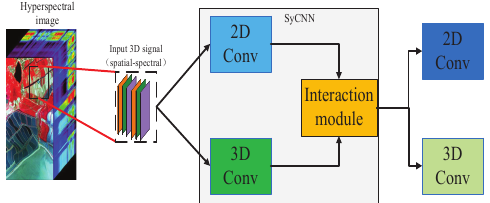
Figure 1. The Synergistic Convolutional Neural Network (SyCNN) framework which integrates 2D CNN, 3D CNN and the data interaction module for hyper-spectral image